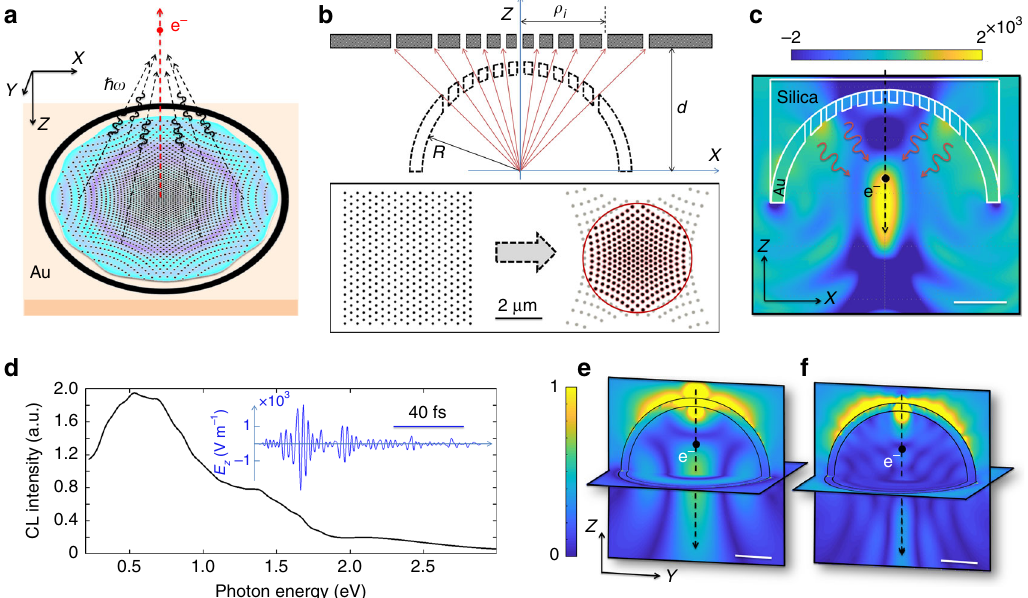
Fig. 1 Design Principle for the broadband light source. a Formation of focused broadband transition radiation in interaction of an electron beam with an engineered planar lens. The structure is designed to effectively mimic a porous hemispherical geometry. b Schematic of the design principles that includes projection of incorporated holes in the hemispherical lens to a planar gold fi lm. c Interaction of a 30 keV electron (incident from the top) with a mesoscopic hemispherical porous fi lm positioned on a silica substrate. The electron passes through one of the holes at the center. Depicted in the fi gure is a snapshot of the simulated z -component of the electric fi eld 22.55 fs after impact on the lens surface which indicates a clear focus. Color bar is in the dimensions of Vm − 1 and scale bar is 1 μ m. d CL spectra of the hemispherical structure computed at a plane positioned 5 micrometer below the structure. Inset: Temporal representation of the z -component of the electric fi eld at the focal point in c . Time-averaged electron-induced electromagnetic wave packet at the energies e E = 0.6 eV and f E = 1.3 eV. Depicted is the magnitude of the Fourier transform of the z -component of the electric fi eld in the xy and yz planes. Color bar is in arbitrary units and scale bars are 1 μ